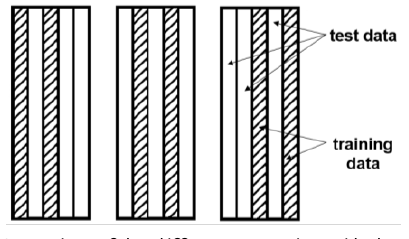
intersections, the three-dimensional positions of the points in object space (i.e. X, Y, Z) are determined. The photogrammetric point clouds obtained from the tri-stereo satellite image matching contain not only the 3D coordinates, but also the reflectance information from the three spectral bands (Red, Green and Blue). In las file format and with a regular distribution (one point per each image pixel) the resulting point clouds have densities of 4 points/m 2 for